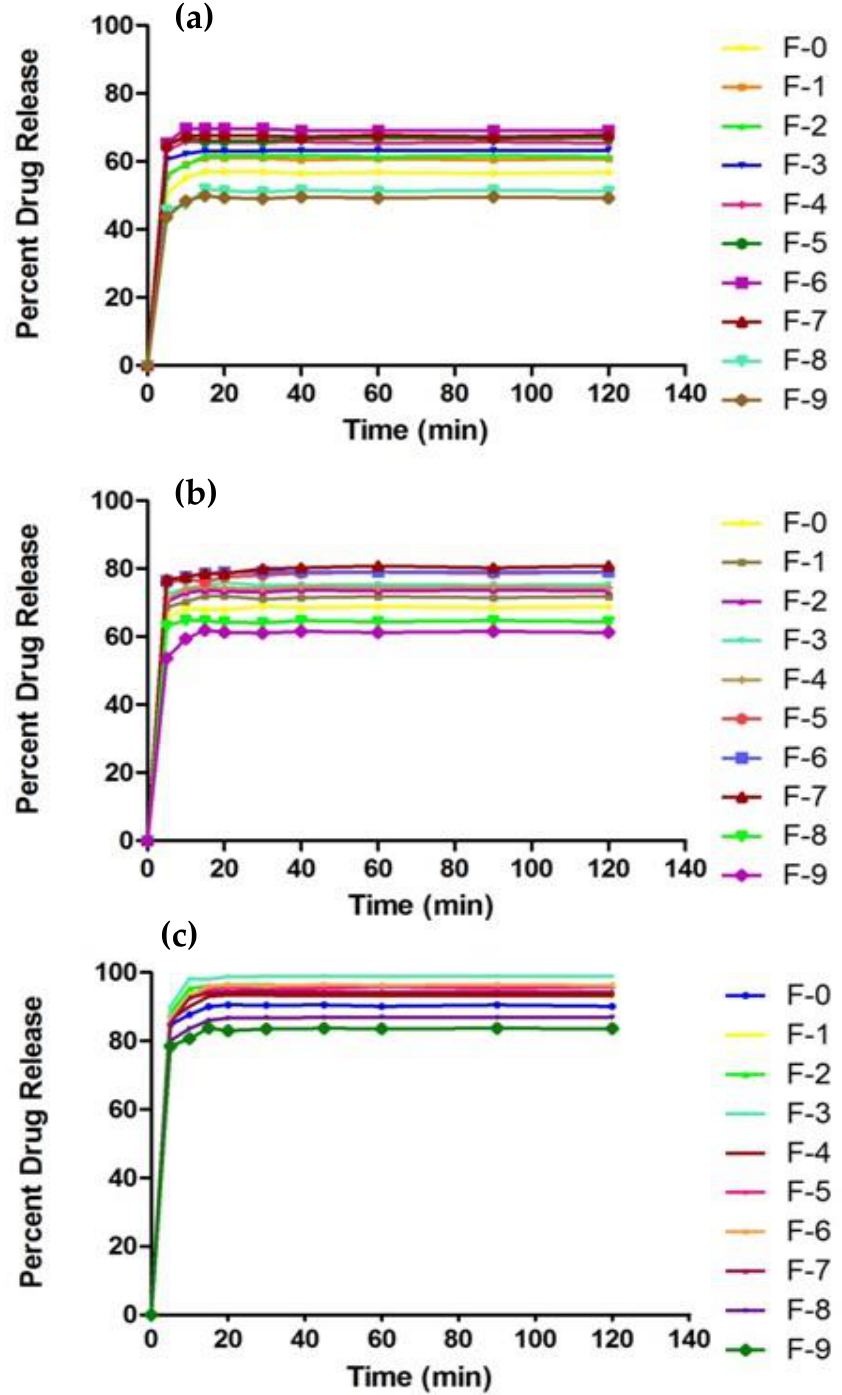
Figure 9. Drug release profiles of formulated nanosponges in buffer solution of ( a ) pH 1.2, ( b ) pH 4.5 and ( c ) pH 6.8.